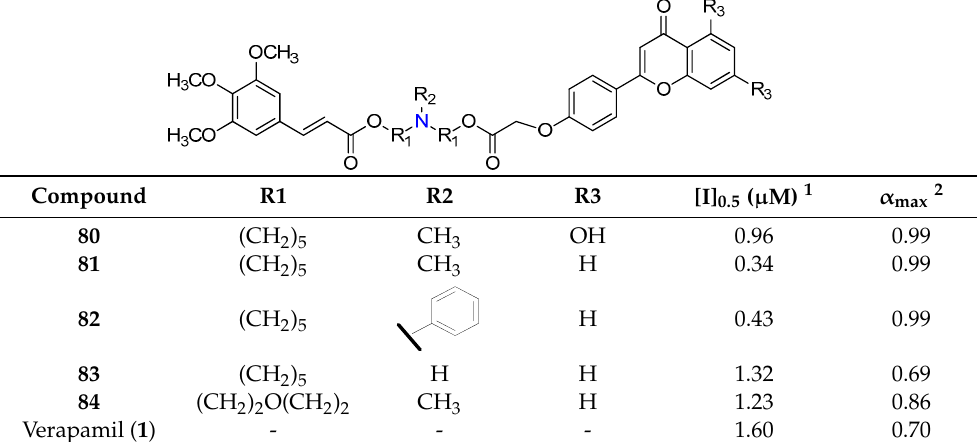
Table 7. P-gp modulating activity of flavone derivatives 80 – 84 on K562/DOX cells [114].